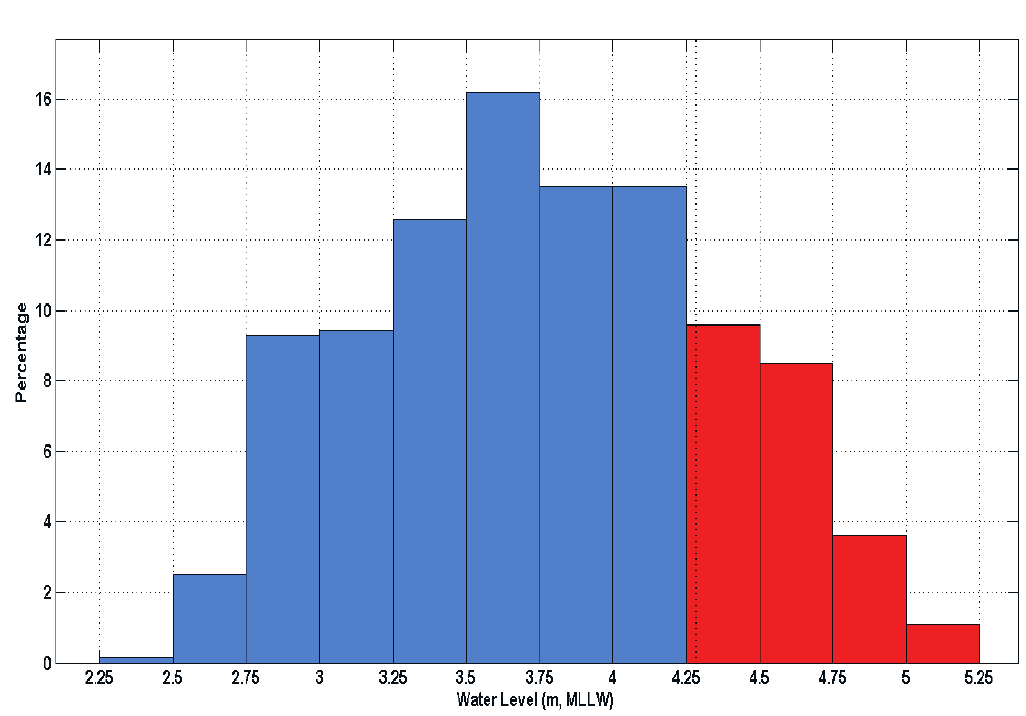
Figure 7. Probability distribution of peak water levels (storm tide rel. to MLLW) at The Battery created by shifting the phase of the tides in steps of 30 min between one tidal cycle before to one cycle following the time of landfall for each of the 11 wind ensemble field (see text for